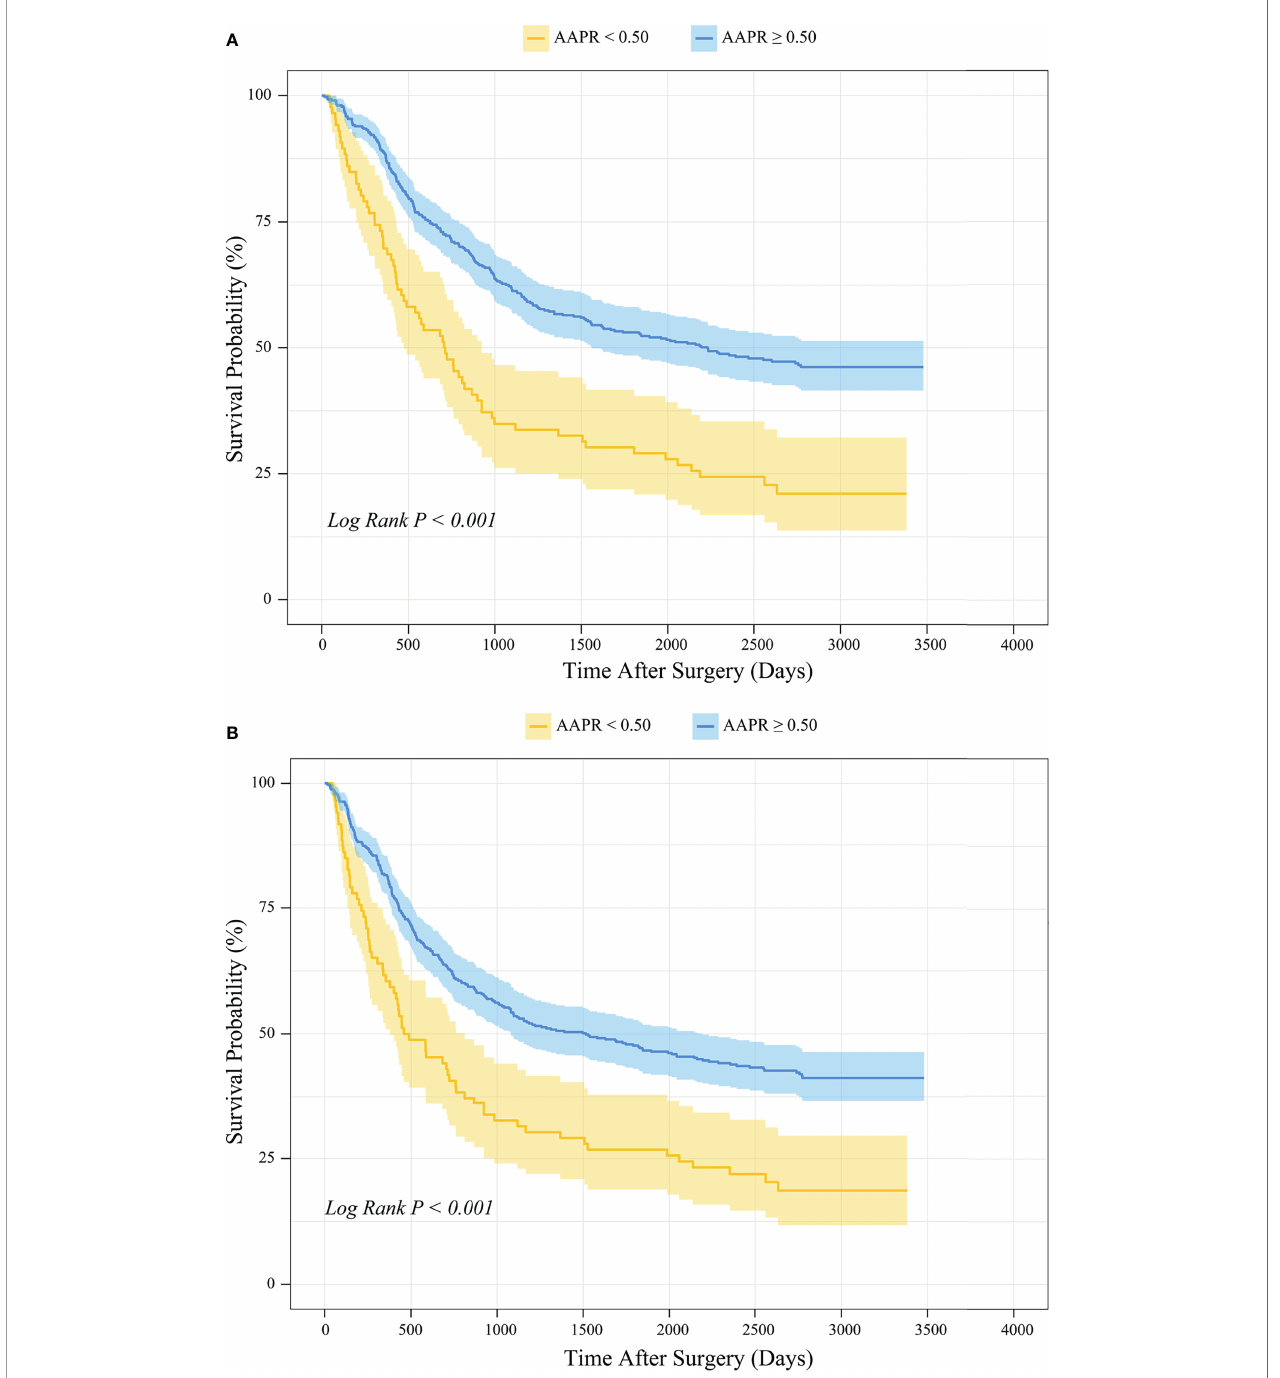
FIGURE 4 | Kaplan-Meier survival analysis of (A) OS and (B) PFS between patients strati fi ed by preoperative